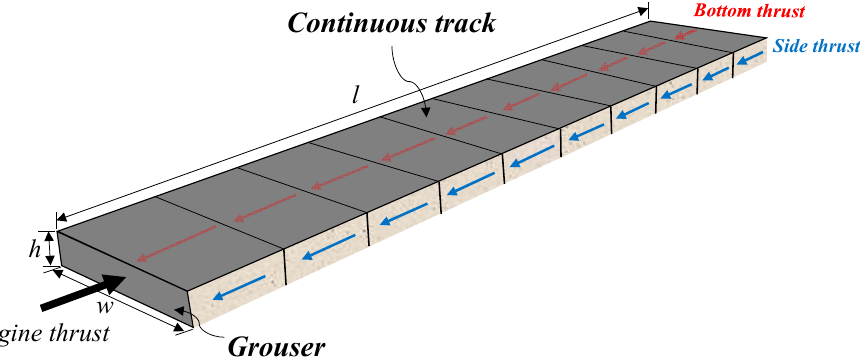
Figure 1. Schematic diagram of soil thrust development at the soil-track interface.